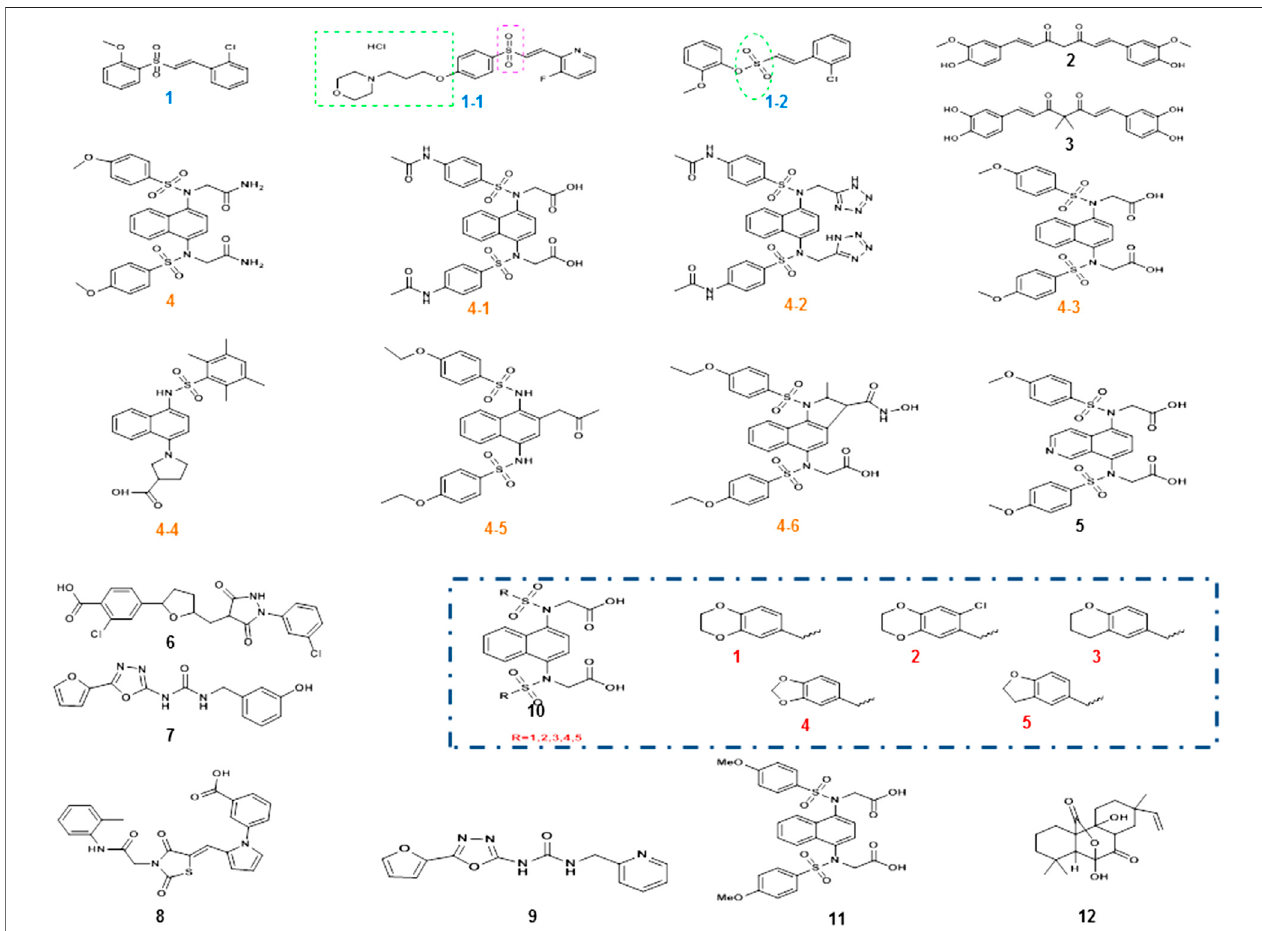
FIGURE 4 | Chemical structures of Nrf2 activators and their analogs. Vinyl sulfone and its derivative compound 1, especially the more active compound 1-1, was obtained after the introduction of its nitrogen heterocycle, and the position of the nitrogen heterocycle was also indicated. Due to the speci fi c toxicity of sulfone, sulfonamide was used instead of sulfone to obtain compound 1 – 2. The α , β -unsaturated carbonyl portion of curcumin compound 2 could bind to cys151 in Keap1 to prevent Nrf2 ubiquitination and proteasomal degradation. Modi fi cation of compound 2 structure yielded catechol derivative compound 3. Compound 4 is a small- moleculeinhibitorof1,4-diaminonaphthalenenuclei,andaseriesofderivativescompound4-1to4-6hadsimilaractivity,whileothernovelcompound8(R=1 – 5)andthe compound 11 were also reported in PD. However, the aminonaphthalene core was not the best choice, giving rise to compound 5 with a 1, 4-isoquinoline core substitution, compound 7 with a 1, 3, 4-oxadiazole core structure, and compound 10 with an optimized structure. Two new structural compounds 6 and 9 were discovered andanother series ofPPIinhibitors containing fi ve-memberedheterocyclic andazole compounds werescreened. Compound 12wasapotentialactivator of the Keap1-Nrf2-ARE